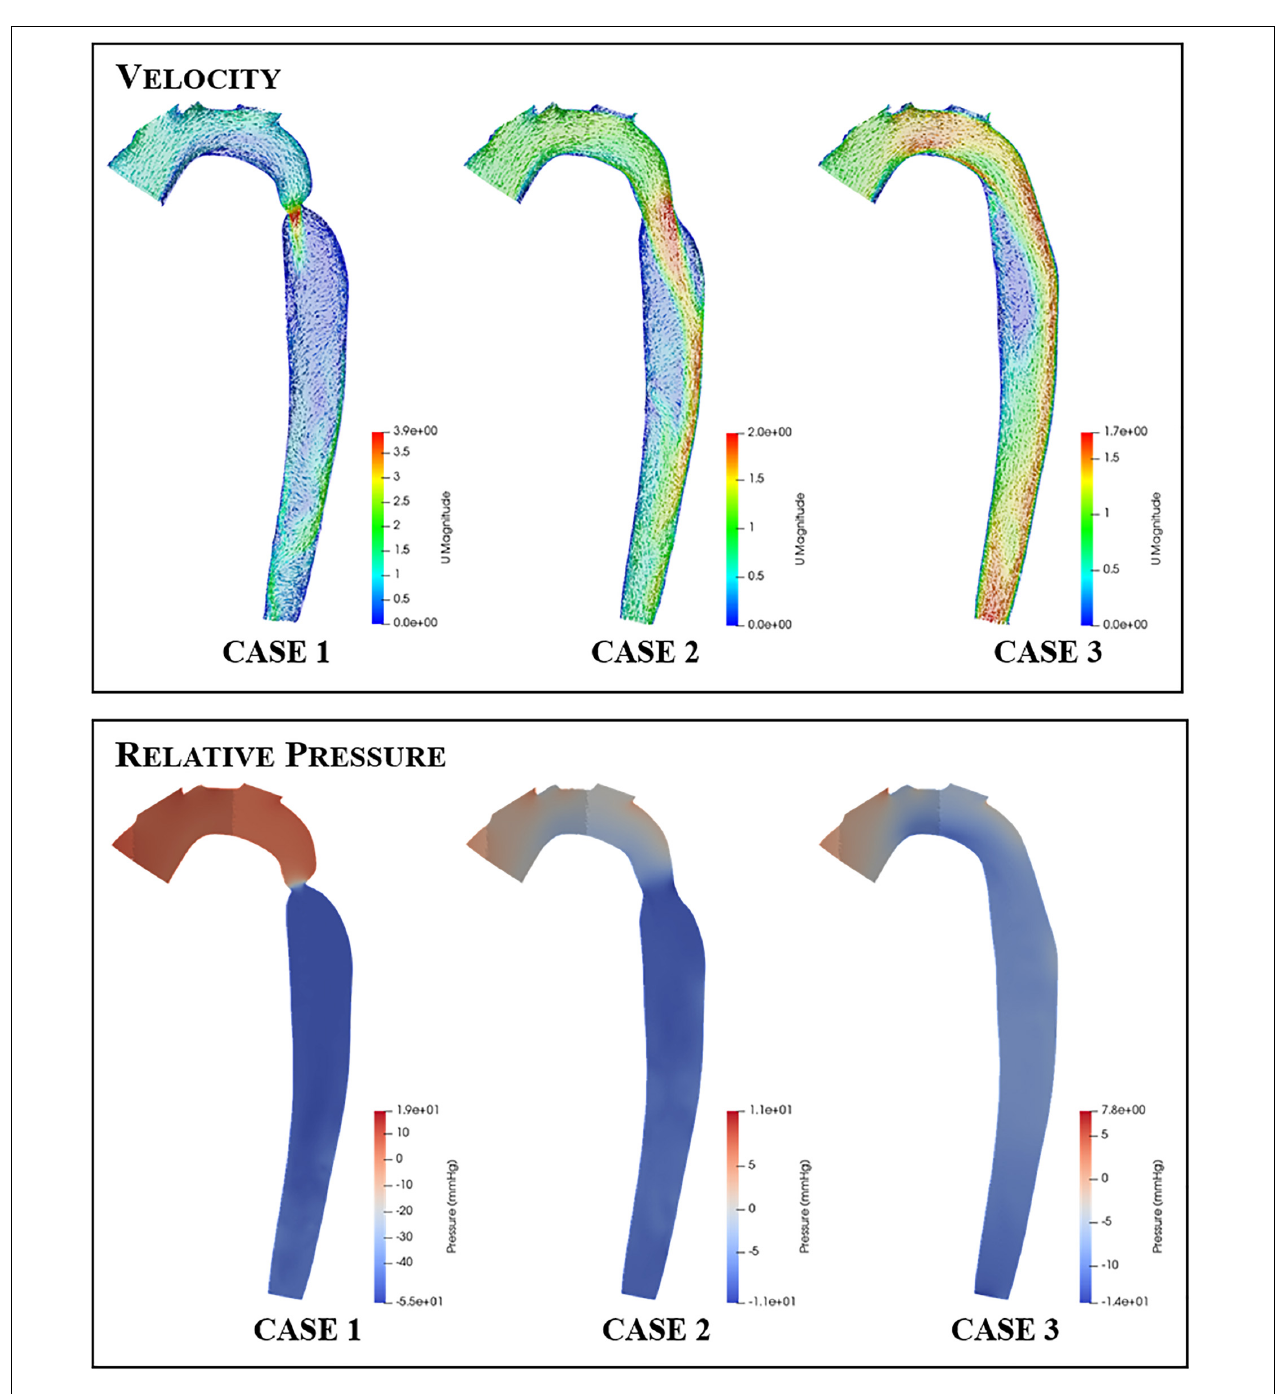
FIGURE 7 | Contour and vector plots along a slice through the aortic arch and descending aorta of the velocity (top row) and pressure (bottom row) fields for each repair